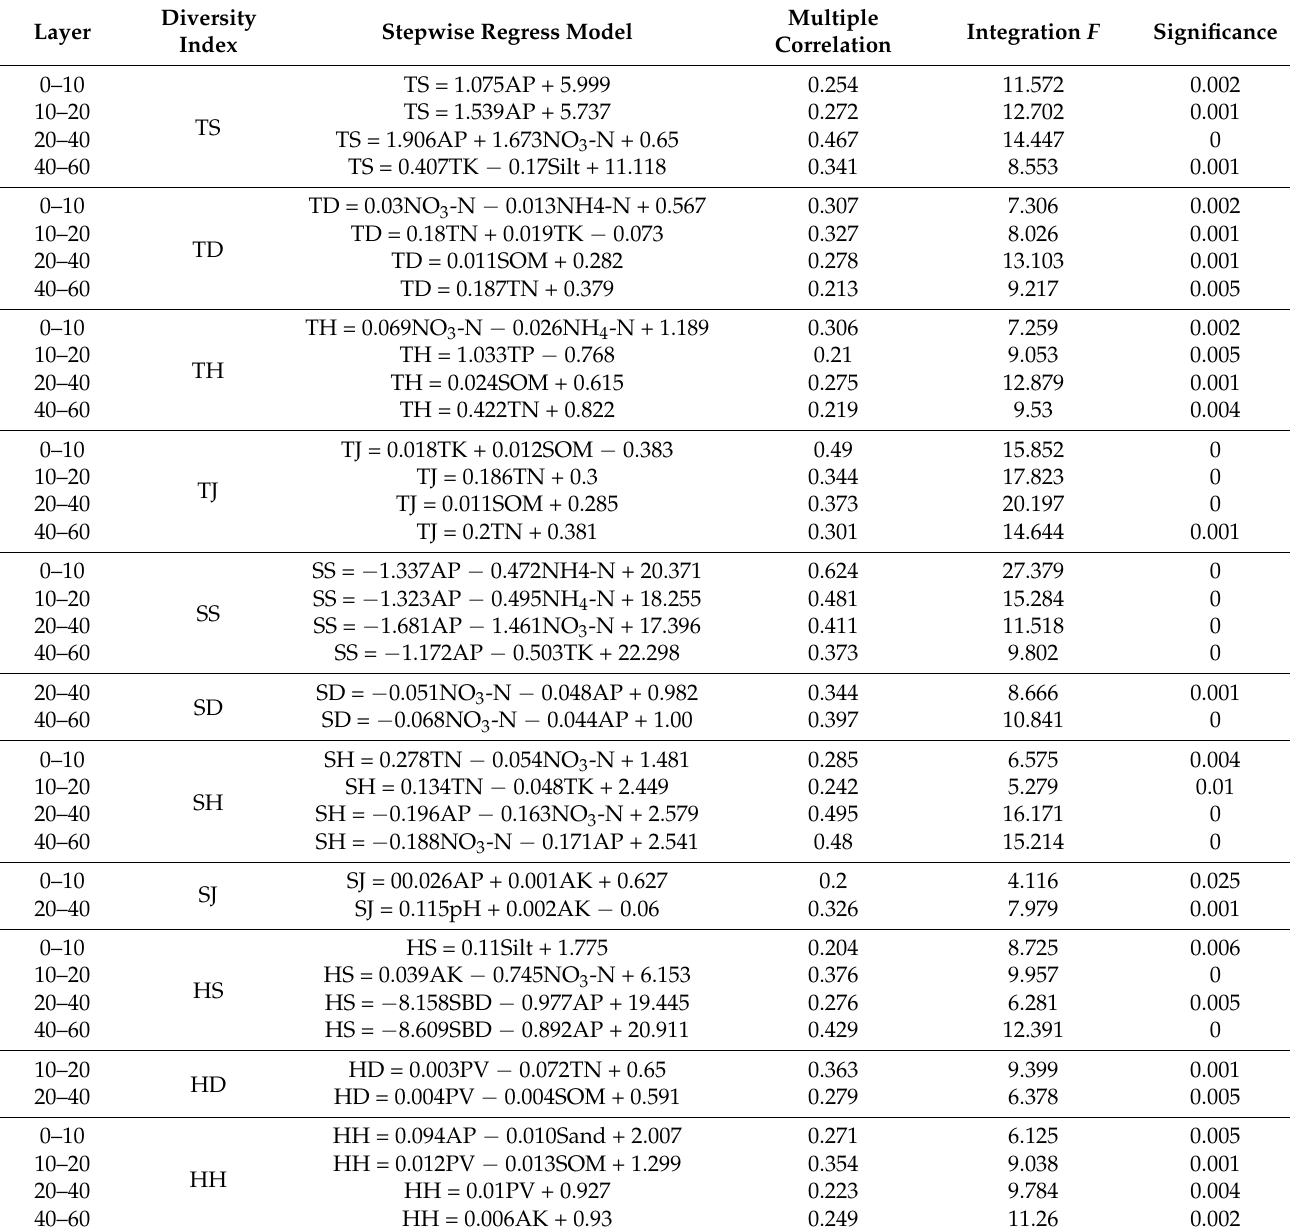
Table 2. Stepwise regression analysis of soil physicochemical properties and four diversity indexes of trees, shrubs and